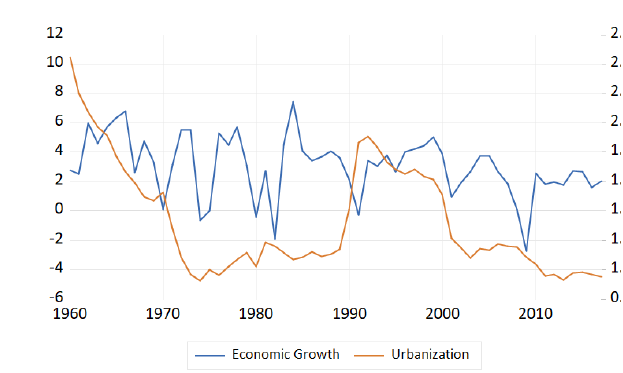
Figure 1. Economic Growth (Left Vertical Scale) and Urbanization (Right Vertical Scale)